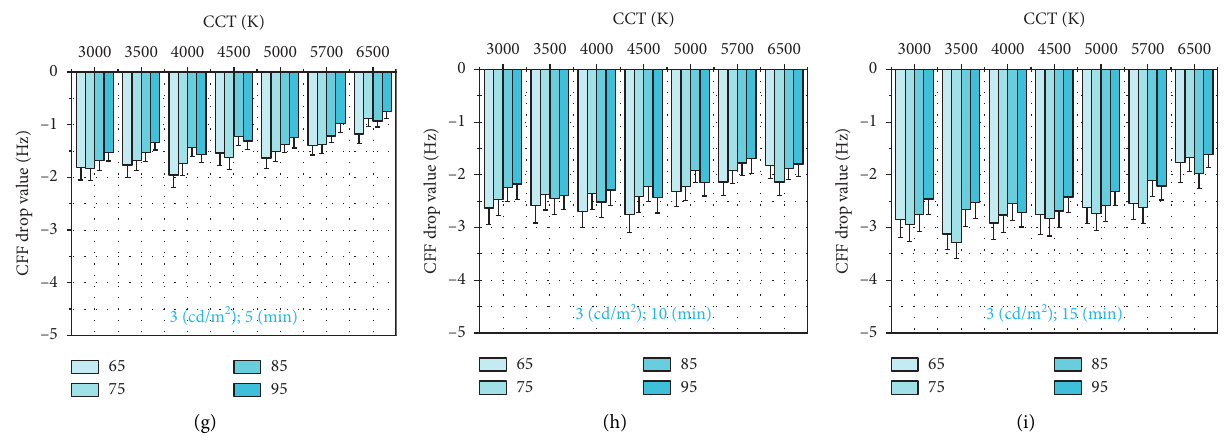
Figure 12: Average CFF drop value. Table 2: P value of significance analysis for the above